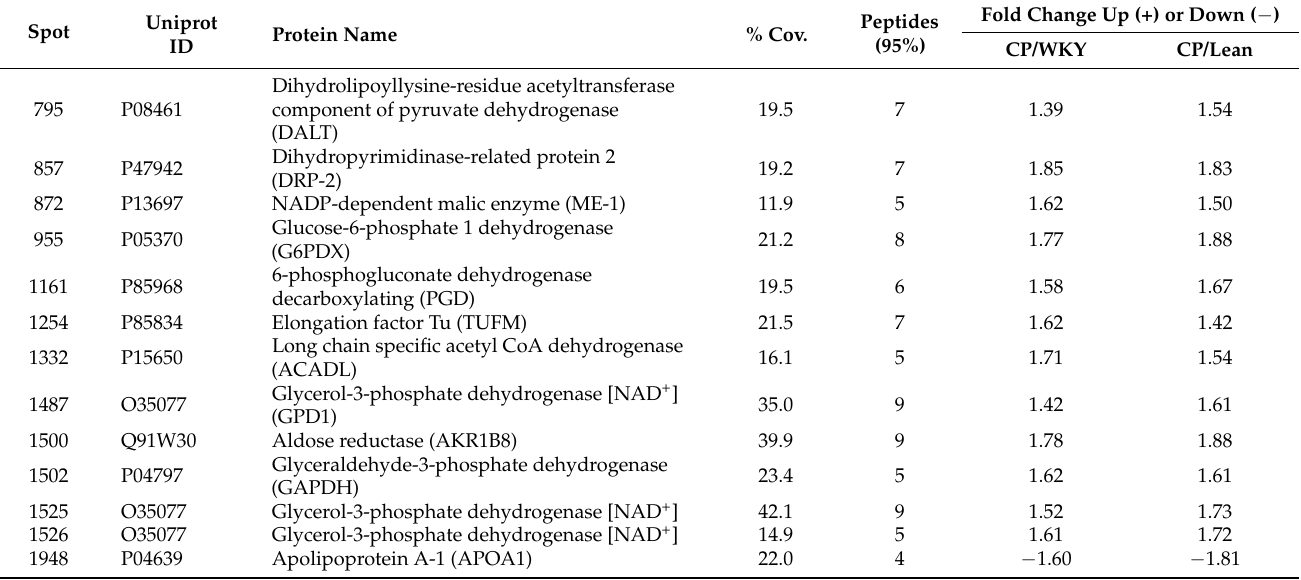
Table 1. List of proteins with significant differences in their levels in epididymal adipose tissues of 6-week-old WKY, Lean, and CP.